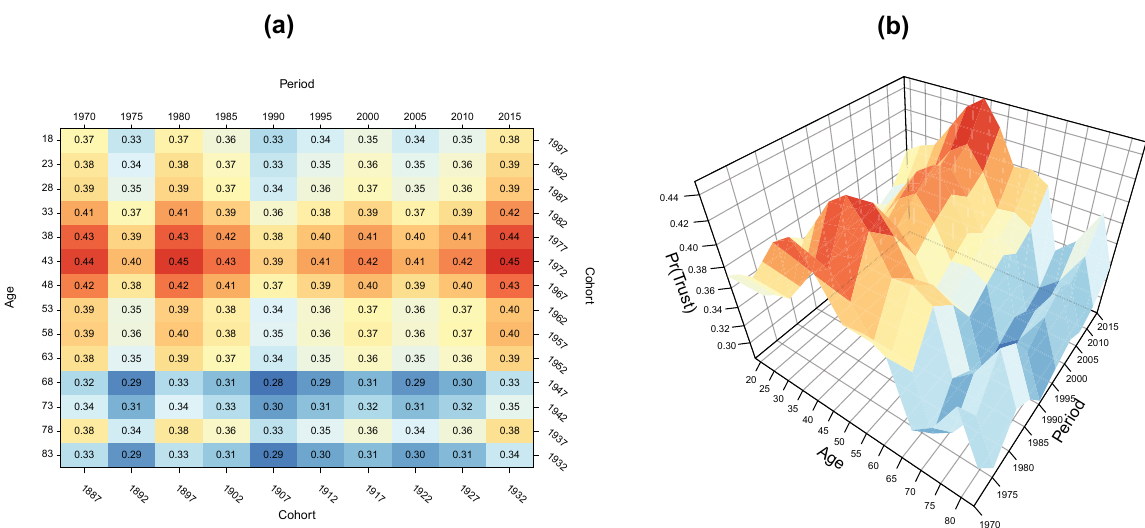
Figure 5: Two- and three-dimensional age–period Lexis surfaces. Notes: (a) and (b) display two-dimensional and three-dimensional Lexis surfaces, respectively, of predicted probabilities of the outcome for all observed combinations of age and period after adjusting for cohort. Calculations are based on θ 1 ( i − i ∗ ) + all observed combinations of i = 1, . . . , I and j = 1, . . . , J . All estimates are derived from a diachronic L-APC logistic regression model. Outcome is social trust, coded so that 1 = “can trust” while 0 = “can’t be too careful” or “depends.” Results adjusted using sampling